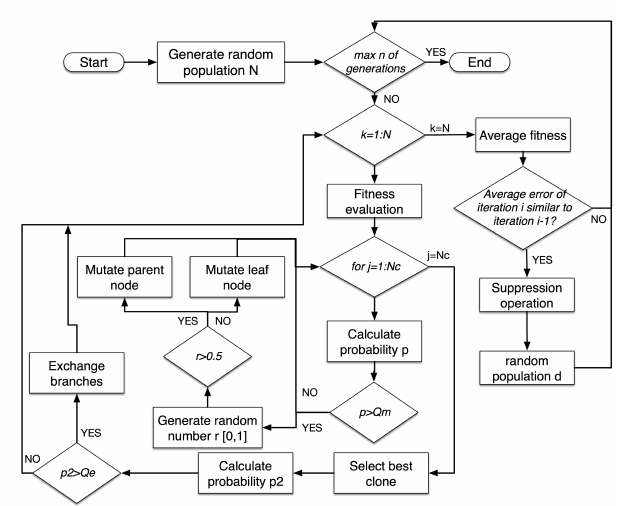
Figure 3. Workflow of the genetic programming (GP) with the artificial immune